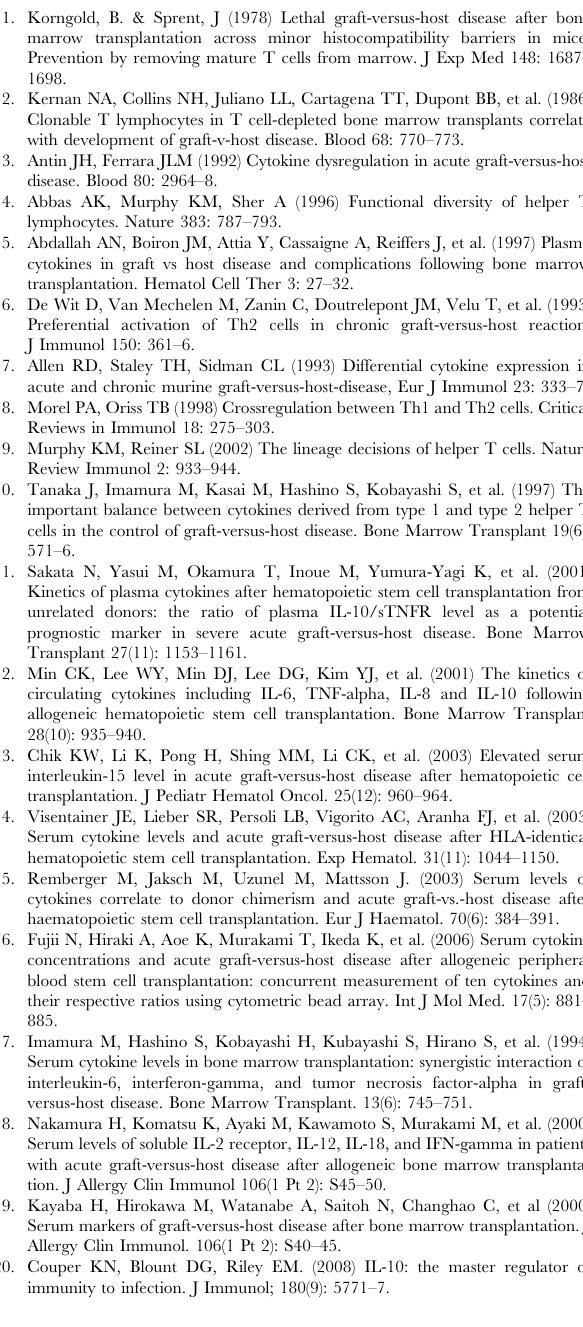
Figure S4 Correlation between sTh1, sTh2, and GVHD. The frequencies of sTh1 and sTh2 are significantly higher when patients had GVHD (figure S4A/S4B, student t -test). The sTh1/ sTh2 ratio was slightly higher in patients with chronic GVHD (figure S4C). Pearson correlation test shows positive correlation between the frequency of sTh1 and sTh2 (figure S4D). Bar represents mean and error bar represents 2X standard error of the mean. (figure S4A/S4B/S4C). Table S1 Characteristics of patients enrolled in this